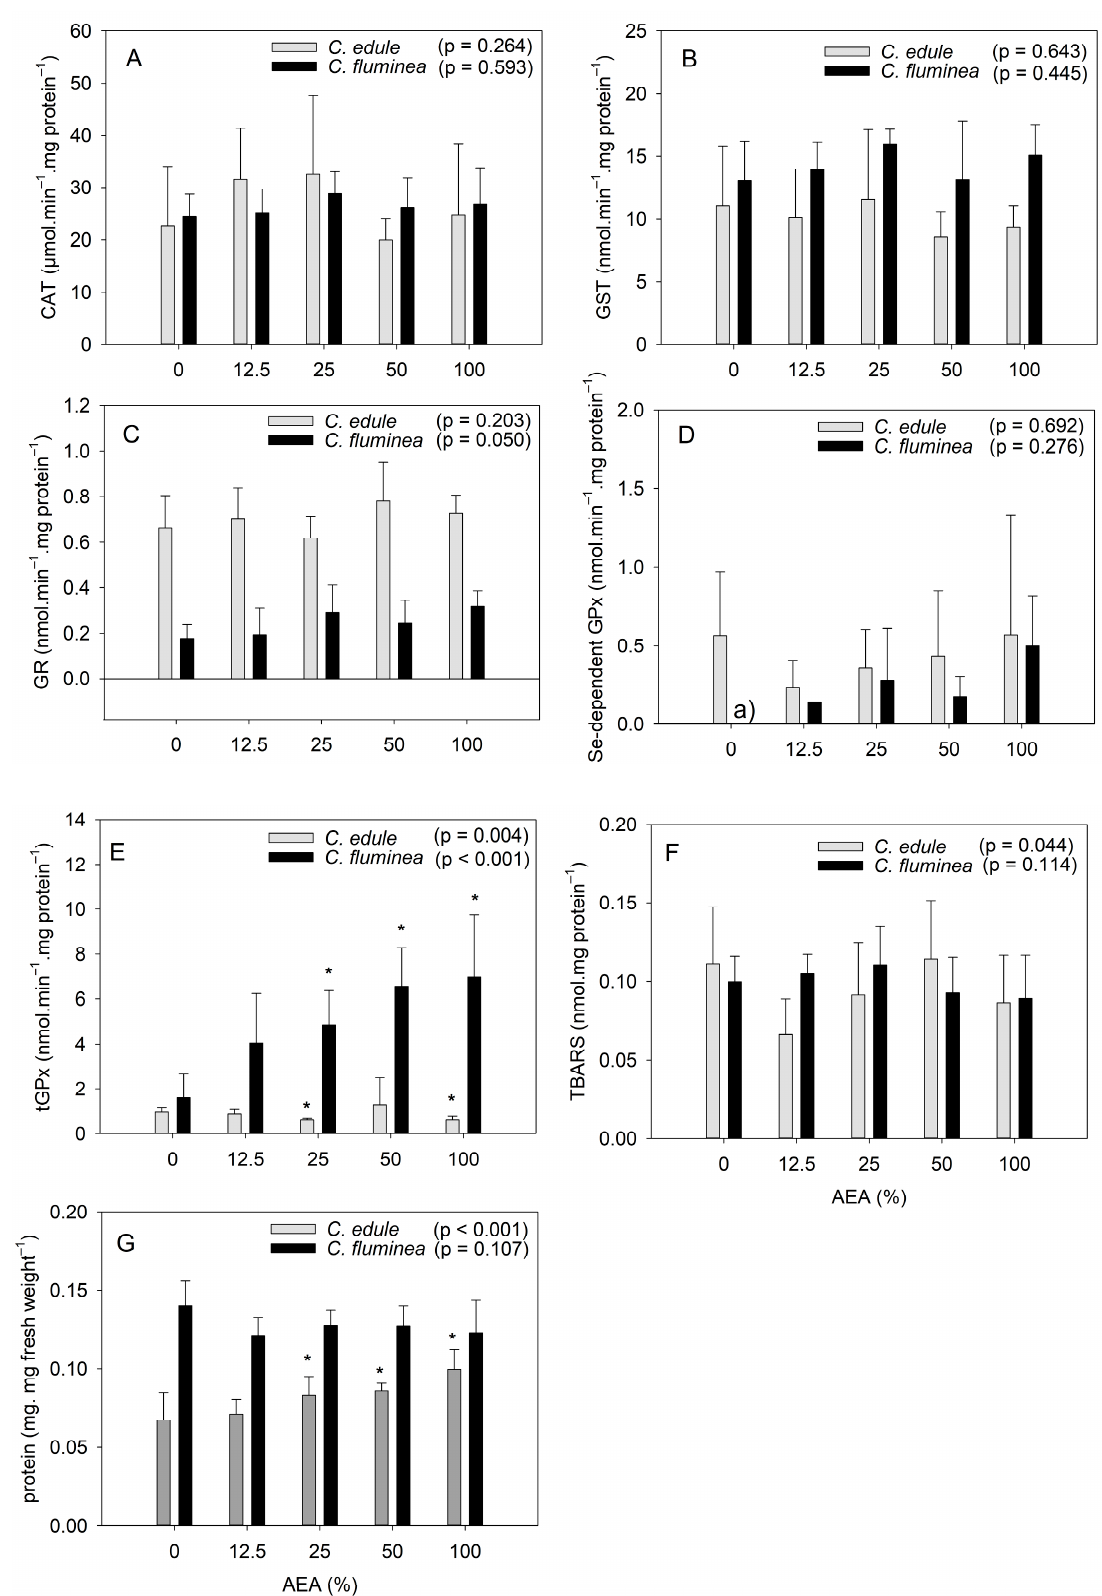
Figure 1. Biochemical responses of Corbicula fluminea and Cerastoderma edule individuals after 96 h of exposure to aqueous extracts of ash (AEA) at different concentrations (0, 12.5, 25, 50, and 100%): activity of the enzymes catalase ( A ), glutathione-S-transferase ( B ), glutathione reductase ( C ),